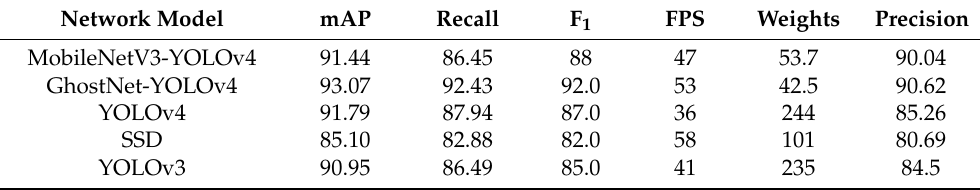
Figure 10. The recognition results before and after applying improvement on YOLOv4. Table 4. Performances of different